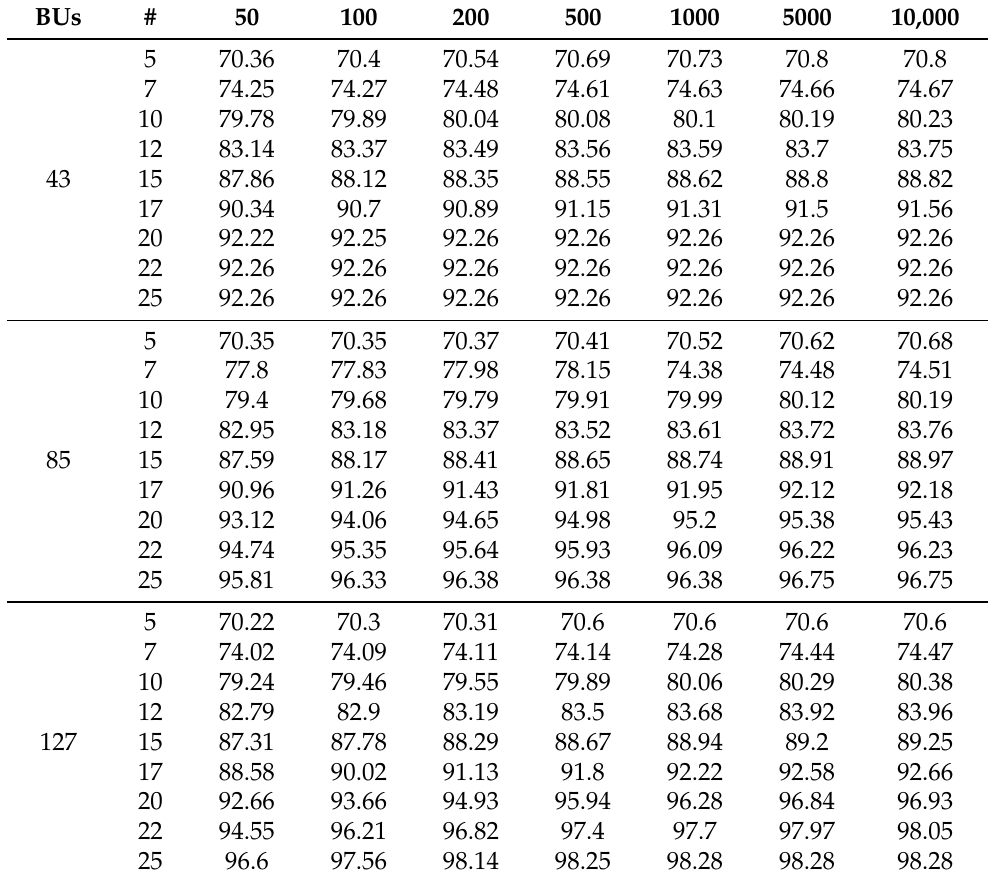
Table 3. Average of late deliveries on the worst day by number of solutions generated during the first phase of the algorithm, Columns ‘50’, ‘100’, ‘200’, ‘500’, ‘1000’, ‘5000’, and ‘10,000’ and instance parameters (number of basic units, column ‘BU’, and number of districts generated, column ‘#’) for instances with high